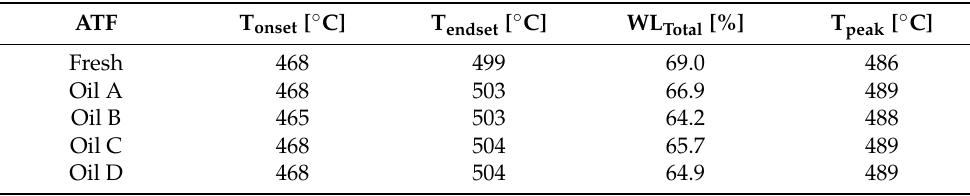
Table 7. TGA and DTGA data of fresh and 168 h aged FKM.